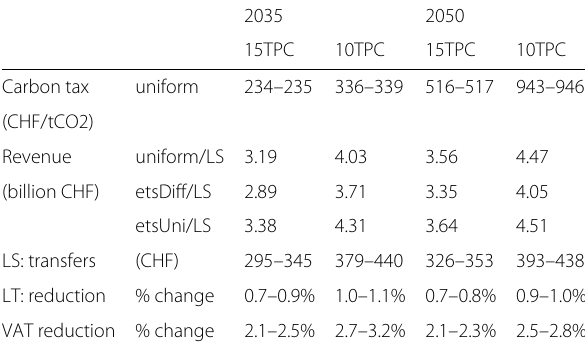
Table 5 Carbon taxes, volumes of revenue for recycling, and the resulting changes in recycling mechanisms for the different scenarios